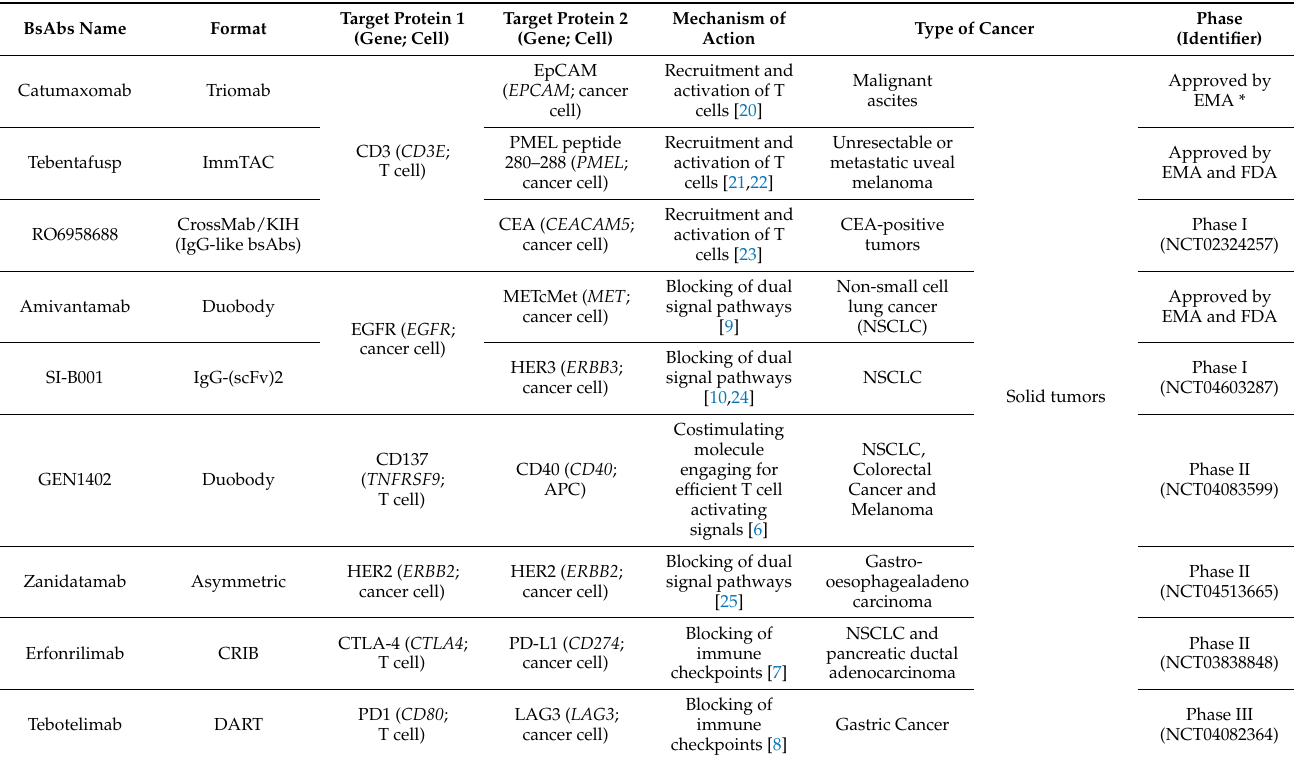
Table 1. BsAbs approved by EMA/FDA and some of the bsAbs in clinical trials for the treatment of solid and hematological tumors. Formats, specificity of Target 1 and Target 2 binding (protein and gene name included), mechanism of action, type of cancer, and clinical phase are